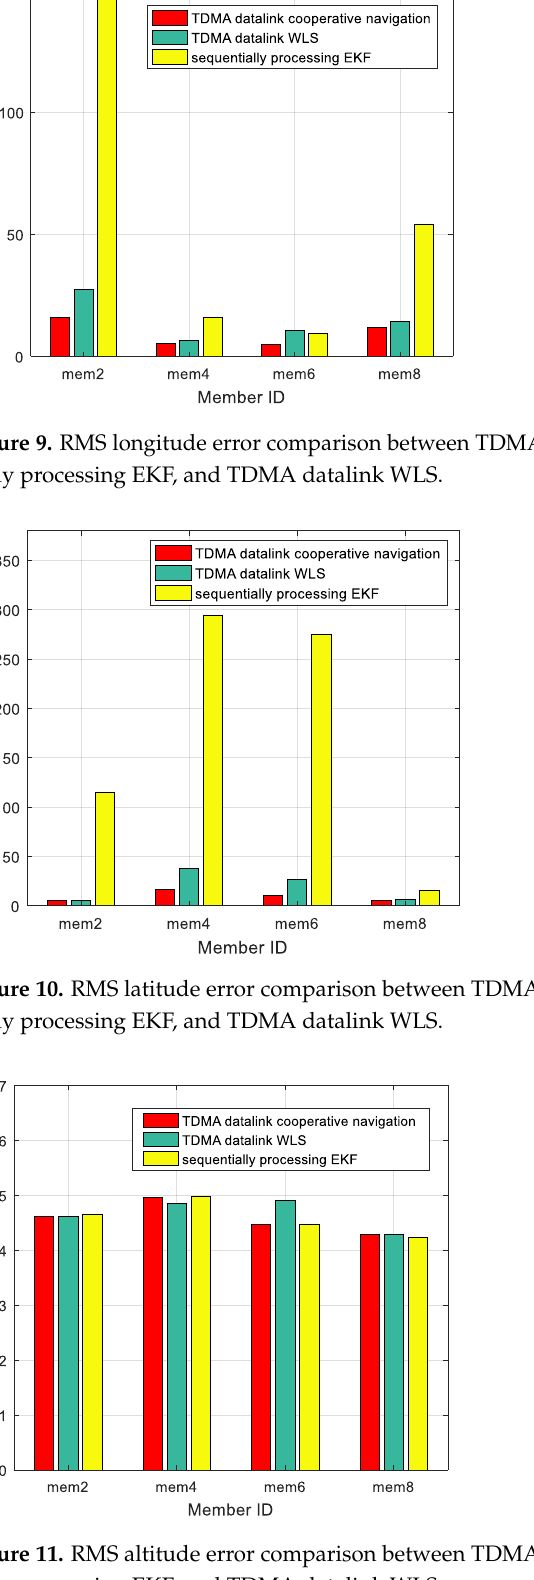
Figure 12. Longitude error comparison between TDMA datalink cooperative navigation algo- rithm, sequentially processing EKF, and TDMA datalink WLS.